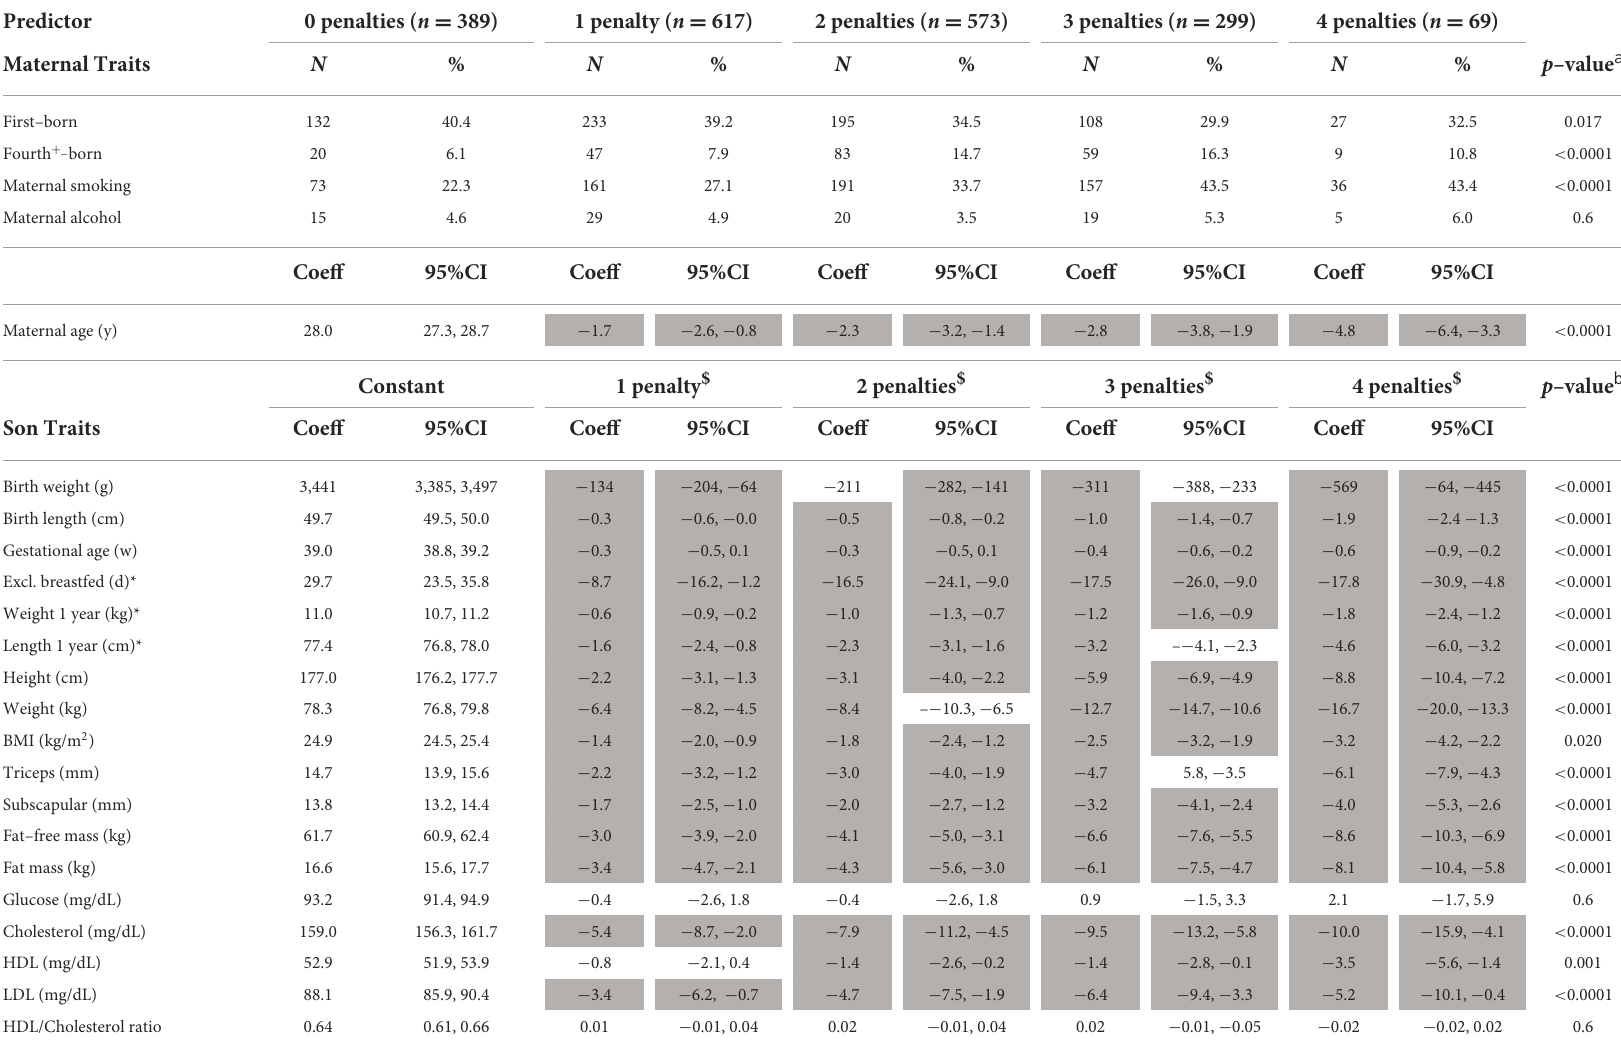
TABLE 3 Dose response associations of maternal or sons’ traits according to the number of penalties in maternal capital. Predictor